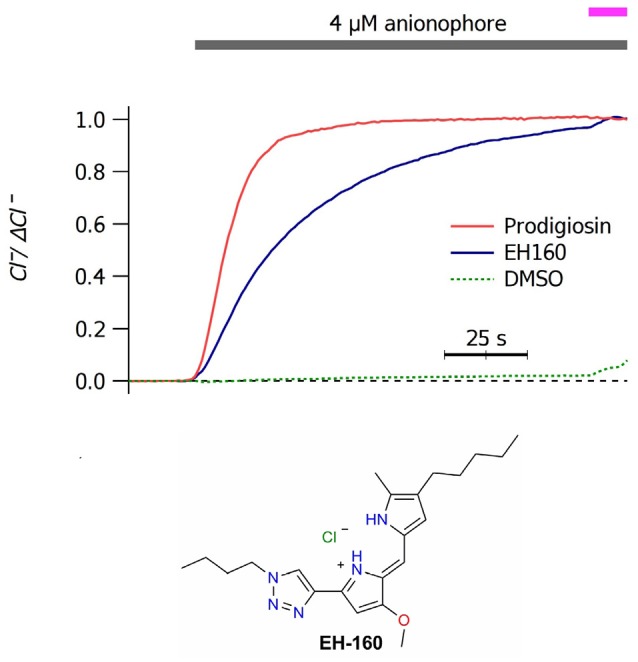
Time course of the external concentration of chloride in a LUV suspension upon application of 4 μM of prodigiosin and EH160, as indicated by the upper bar. The magenta bar indicates the addition of detergent. A control trace was obtained after the application of DMSO. Data was normalized by the maximum chloride change, ΔCl−. The chemical structure of EH160 is shown at the bottom.